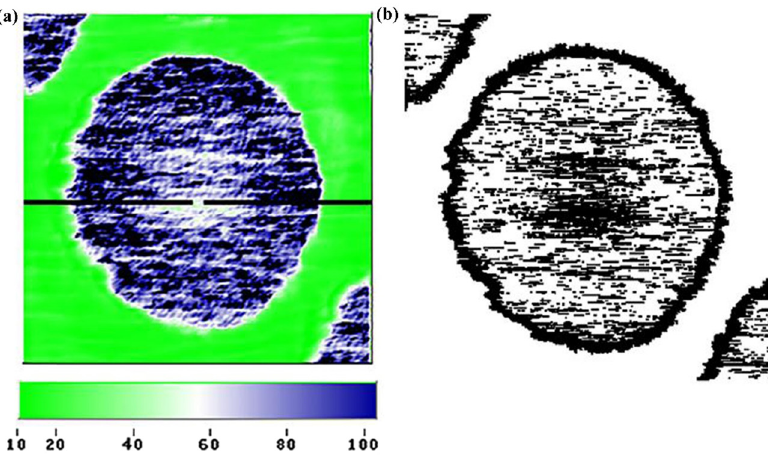
Figure 1: Typical three - color gradient dynamic mechanical image of the CF/PA6 composite: ( a ) storage modulus map and ( b ) interphase dimension and shape [ 8 ]